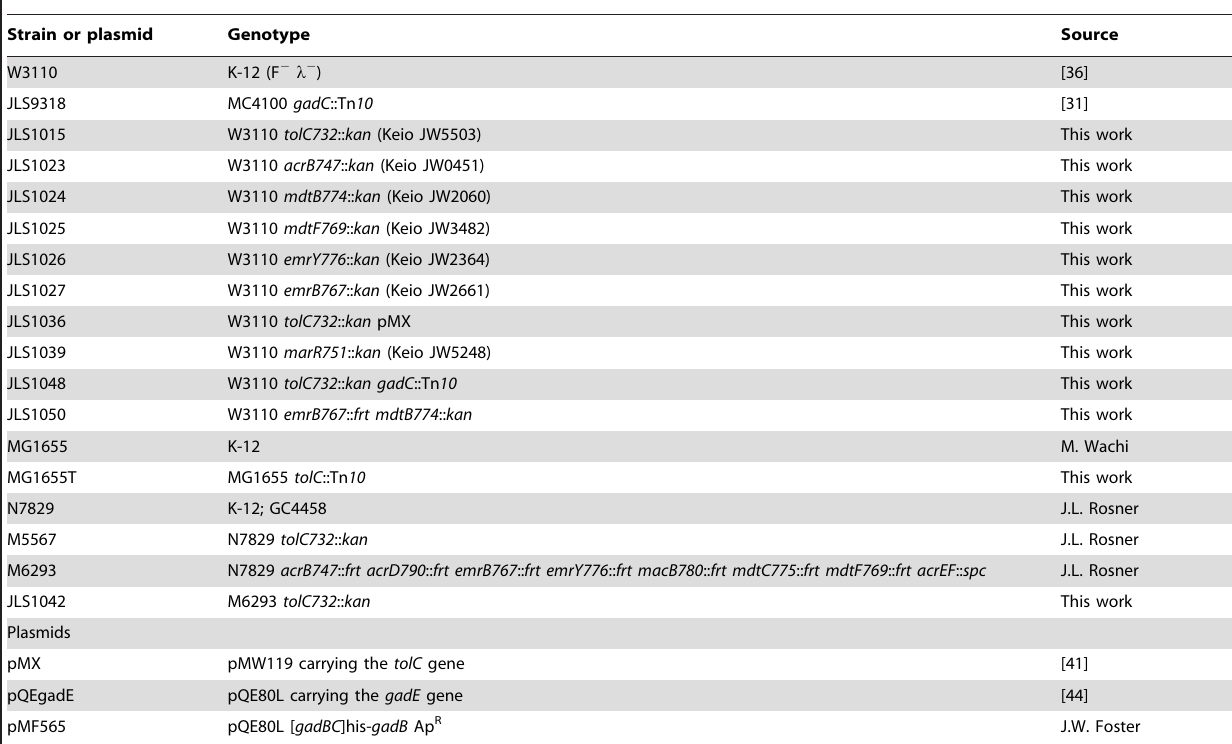
Table 1. E. coli K-12 strains and plasmids used in this study.